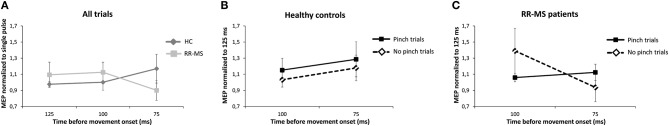
Dual-site TMS (dsTMS) protocol during the Pinch-NoPinch Task. Pre-movement MEP amplitude modulation during the Pinch-NoPinch task. Each line represents the mean amplitude of the MEPs elicited by dsTMS, normalized to the mean MEP amplitude elicited by the single pulse at the same time interval. Error bars indicate standard error. (A) Modulation of MEP amplitude between HC and MS patients over time. (B) Change in PMd-M1 modulation when getting closer to (potential) movement onset for the HC-group, normalized to the mean MEP at 125 ms. (C) Change in PMd-M1 modulation when getting closer to (potential) movement onset for the MS-group normalized to the mean MEP at 125 ms.